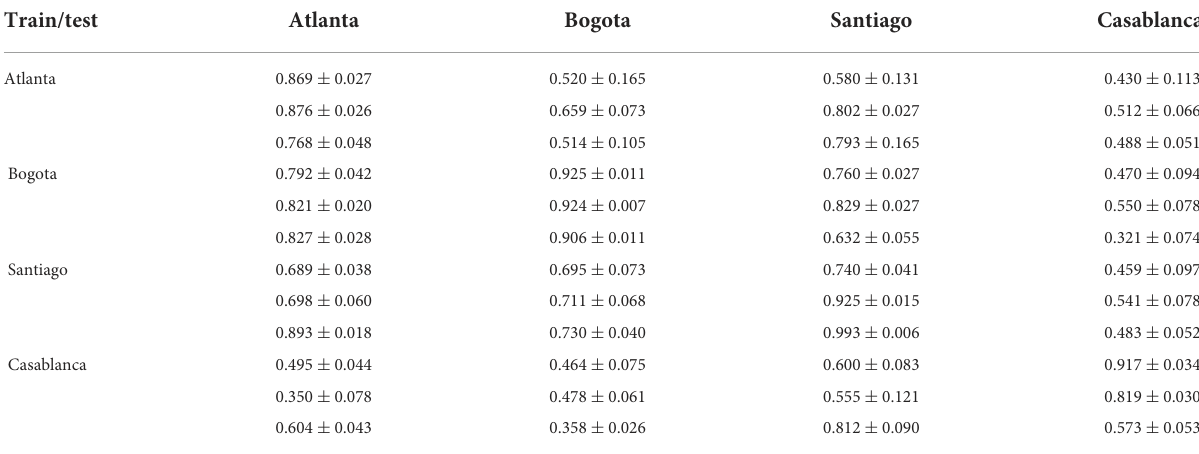
TABLE 5 Performance of classification in terms of ROC-AUC ( ± standard deviation) with classifier trained on city in row and tested on the city in column, with diagonal showing “native” classifiers.